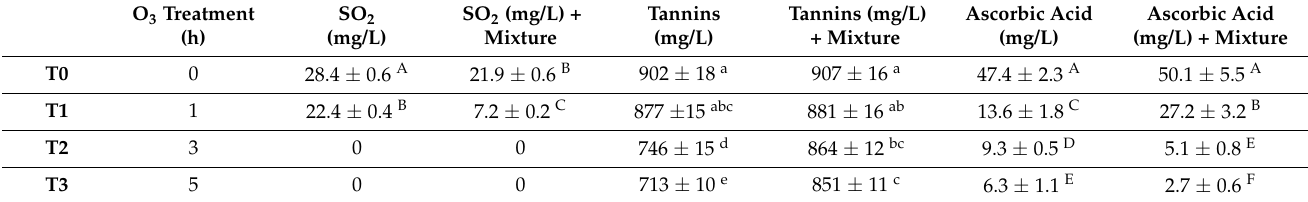
Table 4. Effect of the ozone bubbling (8 µ L/L) on the concentration of the indicated compounds as single product or as mixture with the other two compounds. Data are the mean of three glass jars for each sample ( ± SE), carried out in three to four experiments. In both columns of the indicated compound (SO 2 , tannins, ascorbic acid) as single or mixture, different letters indicate significance at p < 0.01 (capital letters) or p < 0.05 (lower case letters).